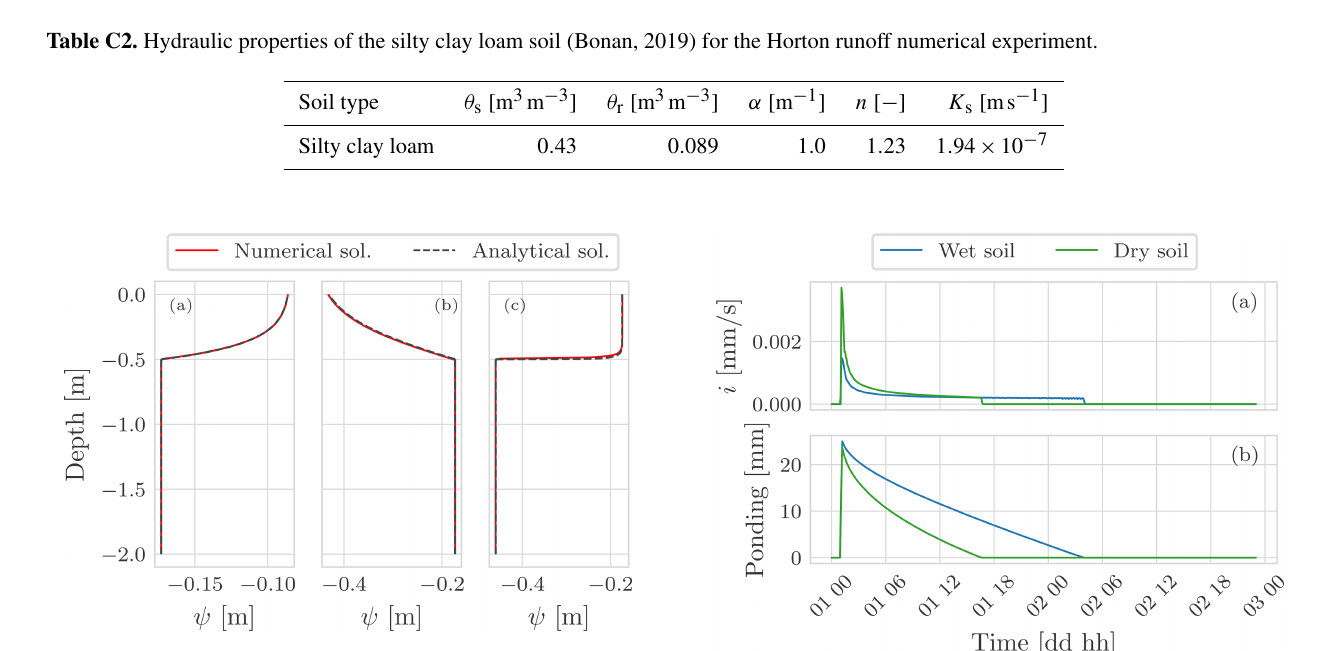
Figure C5. Comparison between the analytical and the numerical solution for the test problem TP3. The three panels show the vertical profile of water suction at steady state for a constant flow rate of 5 . 79 × 10 − 8 ms − 1 : (a) clay–sand soil profile, (b) loam–sand soil profile, and (c) sand–loam soil profile.